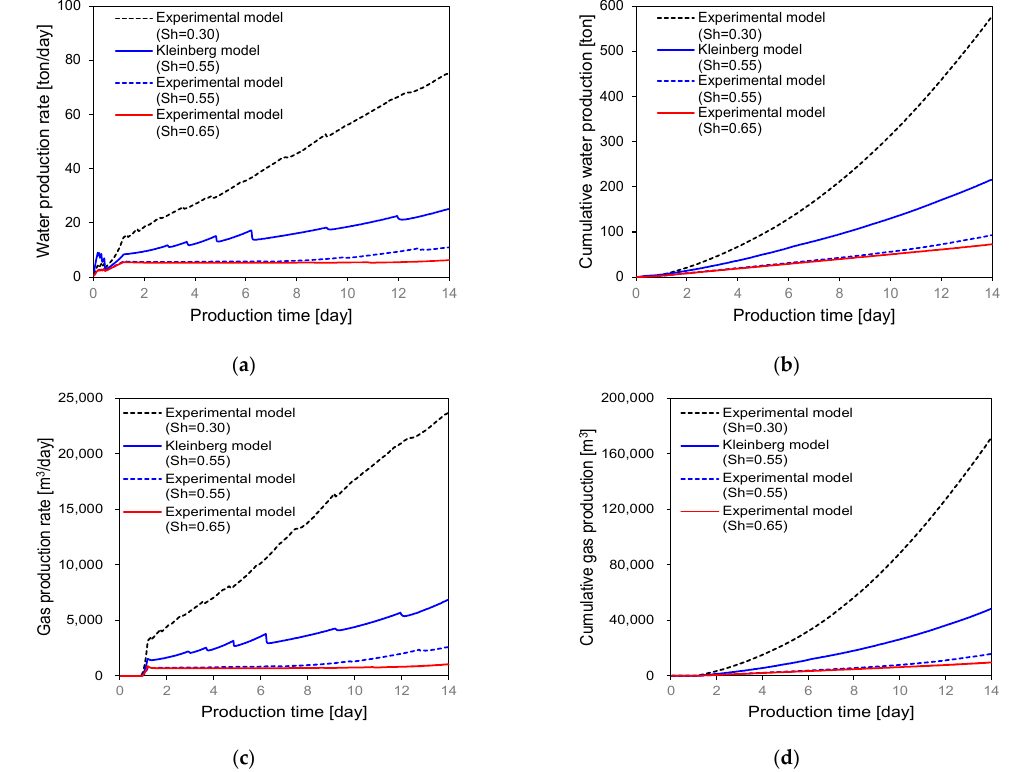
Figure 9. Water and gas production after 14 days for different initial gas hydrate saturations where the experimentally determined permeability model was used: ( a ) water production rate; ( b ) cumulative water production; ( c ) gas production rate; ( d ) cumulative gas production.